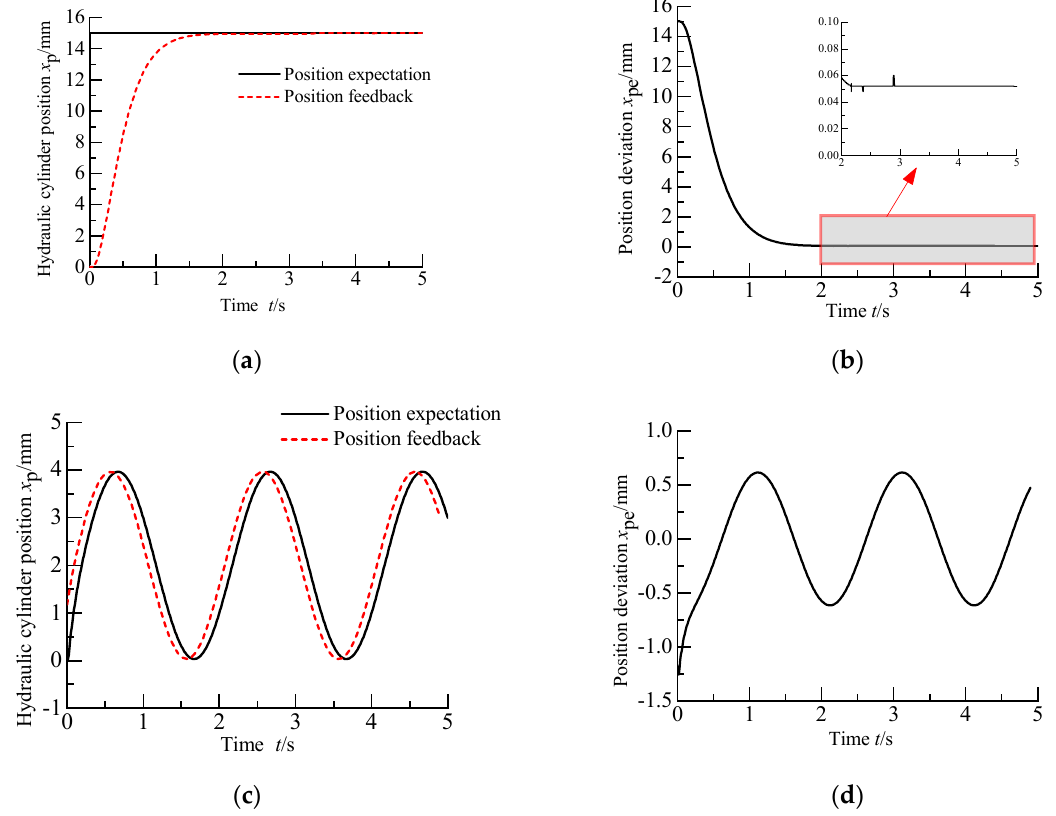
Figure 16. Simulation curve of position control. ( a ) Step position response curve. ( b ) Step position error curve. ( c ) Sinusoidal position response curve. ( d ) Sinusoidal position error curve.